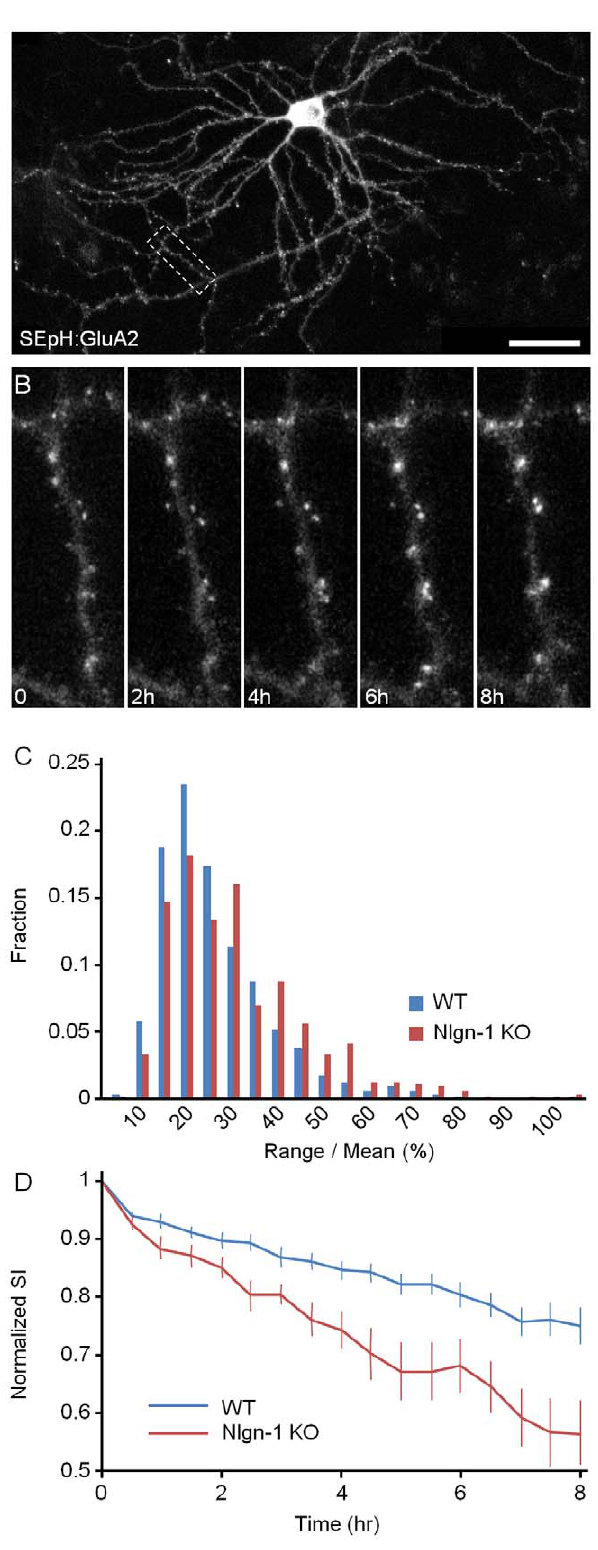
Figure 6. Constancy of AMPAR contents of individual postsyn- aptic sites. A ) A composite image of a cortical neuron from a Nlgn-1 KO mouse expressing SEpH:GluA2. Most bright puncta are located on the postsynaptic membrane of dendritic spines. 19 days in vitro . Bar, 50 m m. B ) Time lapse sequence of region enclosed in rectangle in A. Only a subset of images is shown here. C ) Distribution of range over